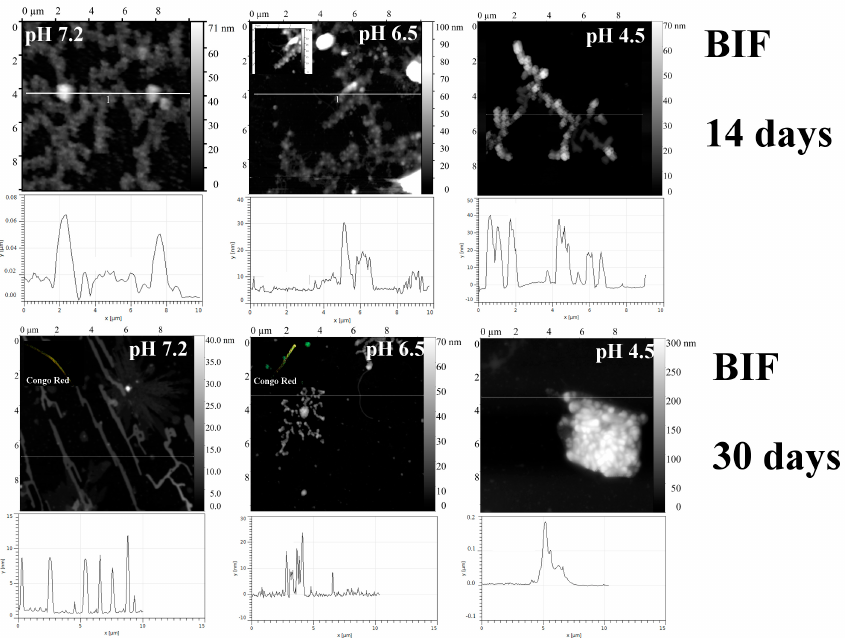
Figure 2. The morphology of BIF aggregates at pH 7.2, 6.5 and 4.5 after 14 days and 30 days of incubation at 37 °C (AFM images obtained in tapping mode). Congo Red birefringence is shown. The data on top were taken from [6]; the authors (Timchenko M.A., Timchenko A.A.) retain the right to use the images in other works according to copyright transfer agreement.